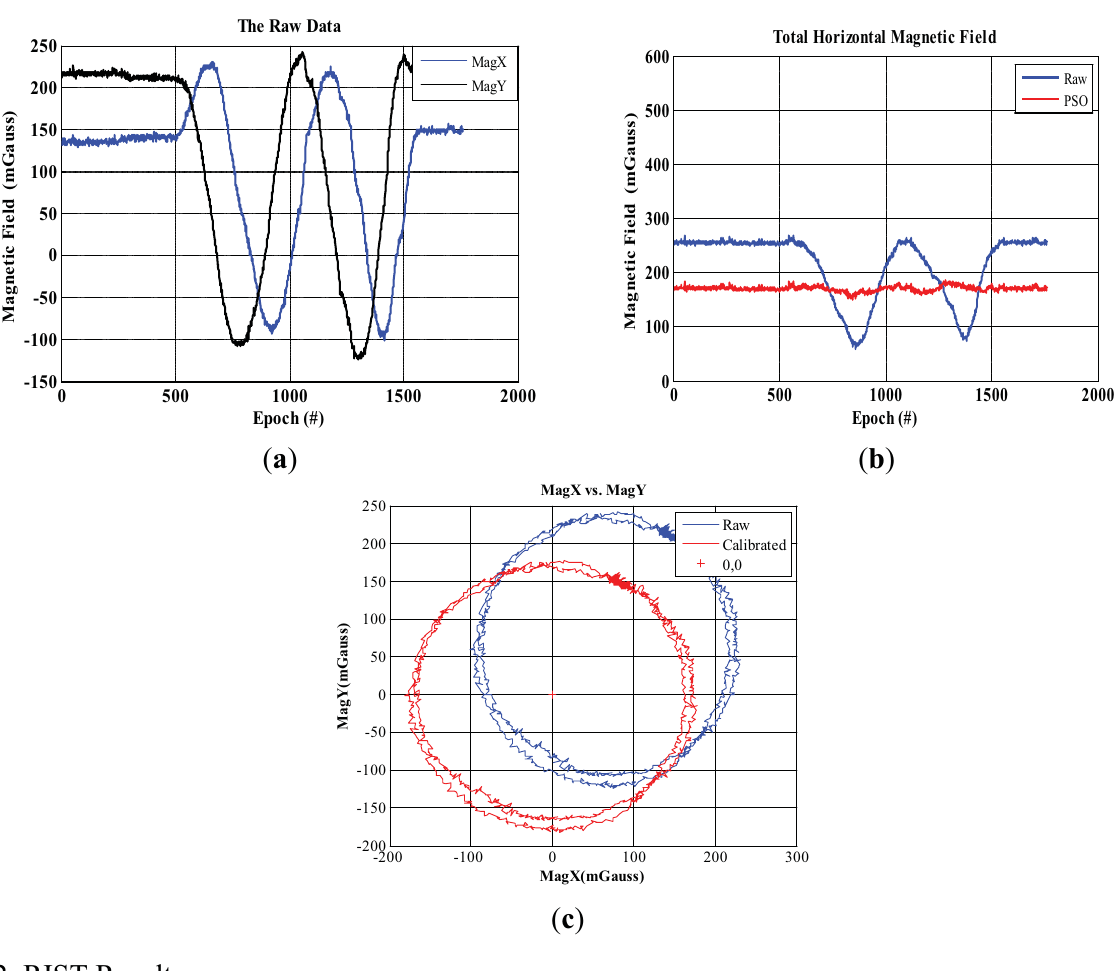
Figure 6. Basic PSO calibration. ( a ) Raw magnetic field. ( b ) Horizontal raw and PSO calibrated magnetic field. ( c ) 2-D calibration for adjusted magnetic